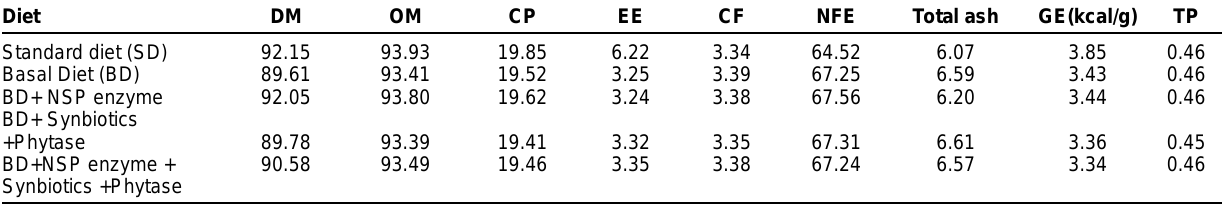
Table-4. Nutrient composition (% dry matter basis) of broiler finisher standard and basal diets (analyzed) Diet